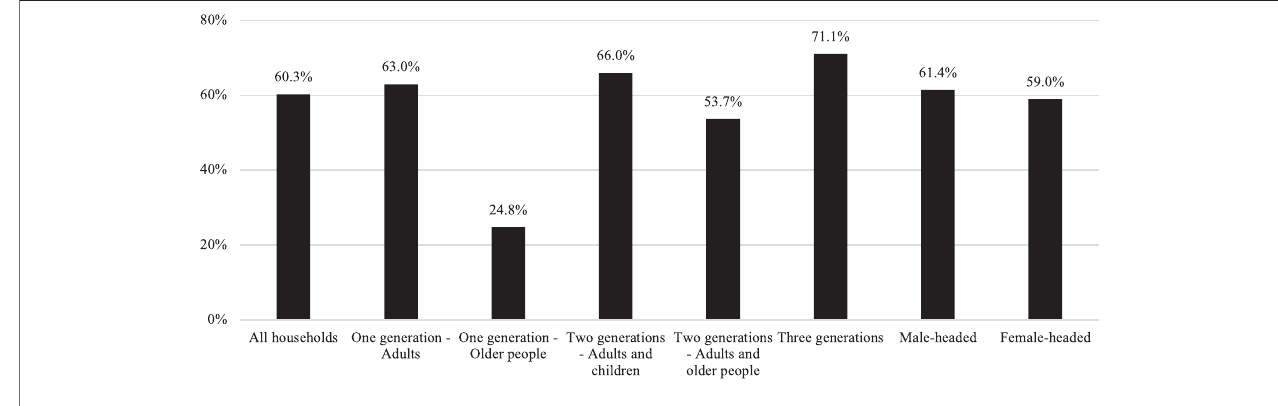
FIGURE 1 | Households reporting a decrease in household income, by household composition and headship. Notes: Sample weights applied. Differences by household type are signi fi cant at p < 0.001. Differences by headship are not signi fi cant.